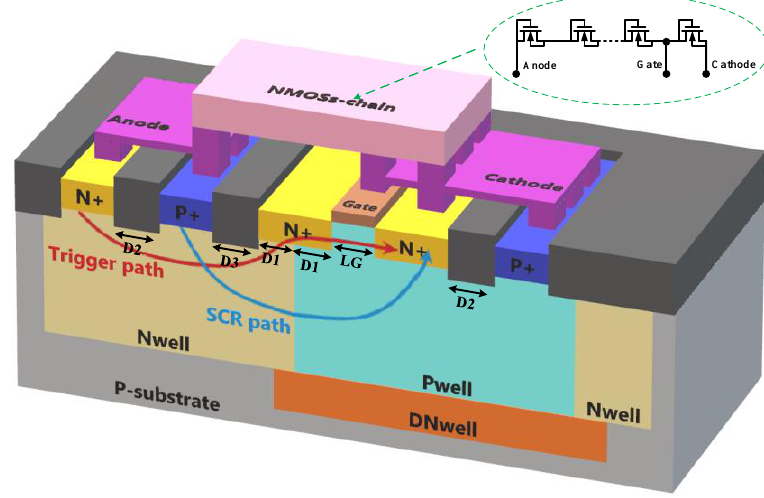
Figure 1. Schematic cross-section of the proposed ULVTSCR device.